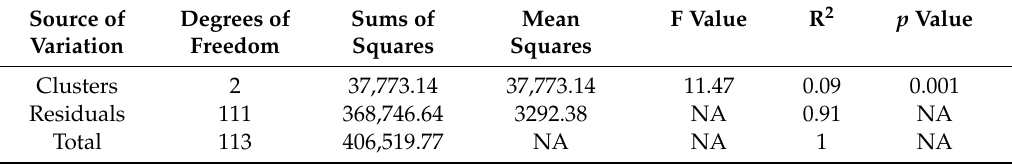
Figure 4. Neighbor-joining clustering of the population of the 114 sorghum lines evaluated in this work. Cluster A (slightly desaturated blue color), Cluster B (vivid orange color), Cluster C (dark-cyan color). Table 2. Analysis of molecular variance